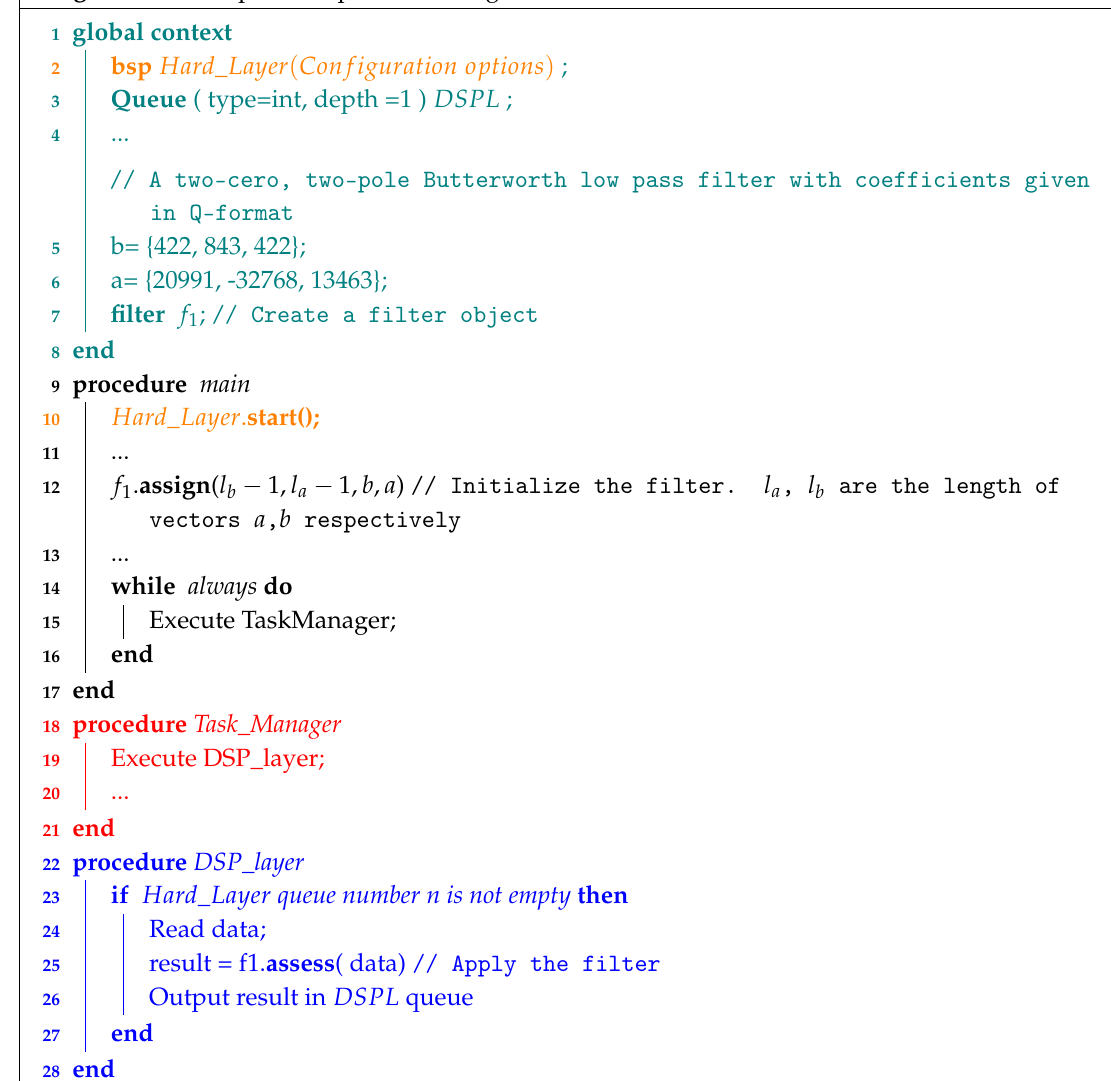
Algorithm 3: Simple example illustrating how to use the filter